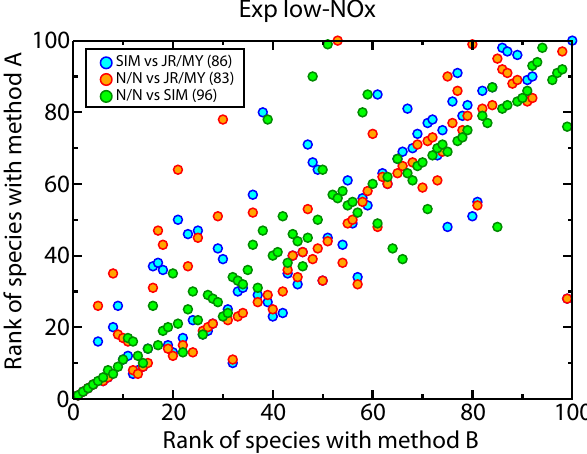
Fig. 7. Comparisons of the ranks of the simulated top 100 organic species between the various methods in the low-NO x